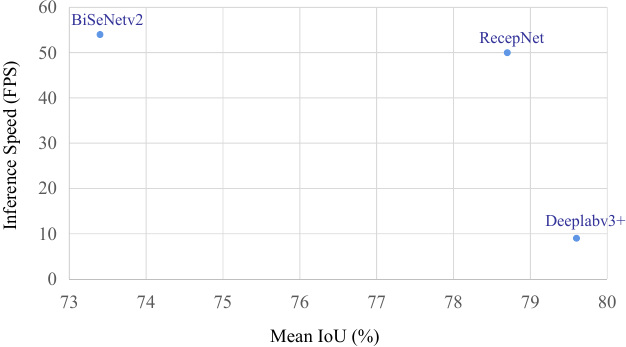
Figure 16. Comparison of three networks. Axis x denotes mIoU. A network placed higher in Axis x shows higher accuracy. Axis y denotes inference speed in FPS; A network placed higher in Axis y shows faster inference